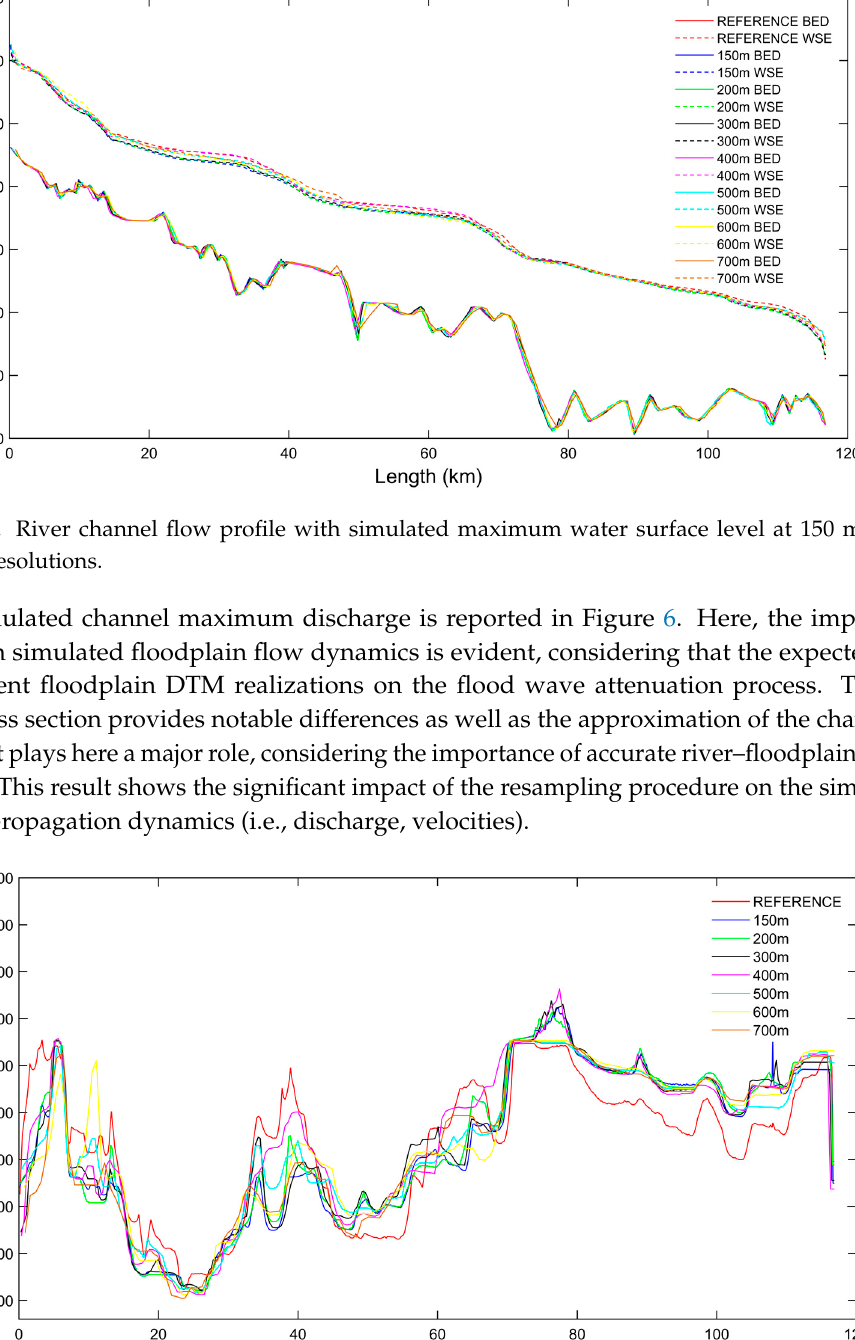
Figure 4. Plots of channel top width ( a ), depth ( b ) and flow area ( c ) using the different model set ups: from the 150 m reference model using the naturally surveyed cross sections to the seven realizations of the synthetic rectangular channel flood model for 150 m, 200, 300 m, 400 m, 500, 600 m and 700 m resolutions.